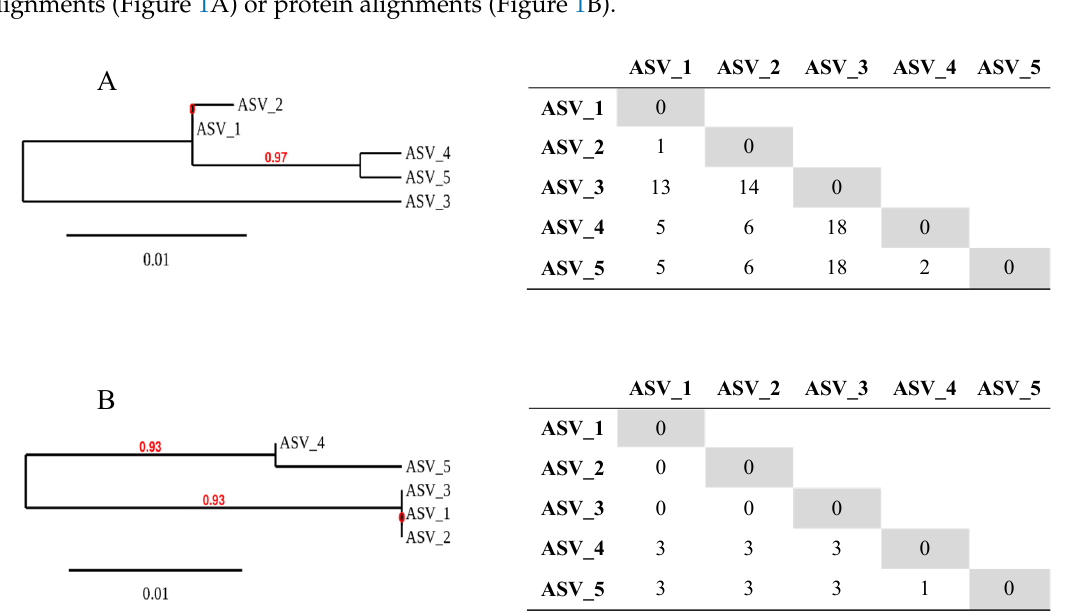
Figure 1. Dendrograms showing sequence similarities of L. lactis strains based on a cluster analysis of the purR amplicon nucleotide variants ( A ) or amino acid variants ( B ). purR genes were sequenced from the undefined mixed starter culture (UMSC) global genomic DNA extraction. The tree was constructed using Phylogeny.fr [46]. Matrix tables highlight di ff erences in the composition of nucleotide ( A ) or amino acid ( B ) sequences.